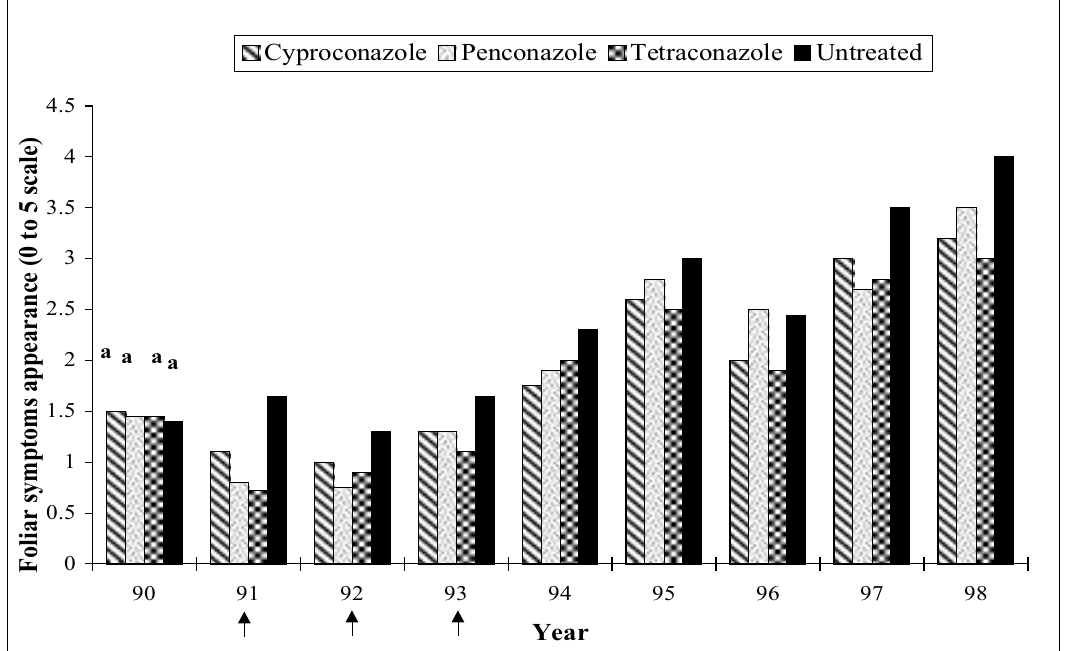
Fig. 1. Injector-pole field trial (cv. Cabernet). Black arrow means fungicide application. For each year values are not statistically different ( P =0.05) according to Duncan’s multiple range.